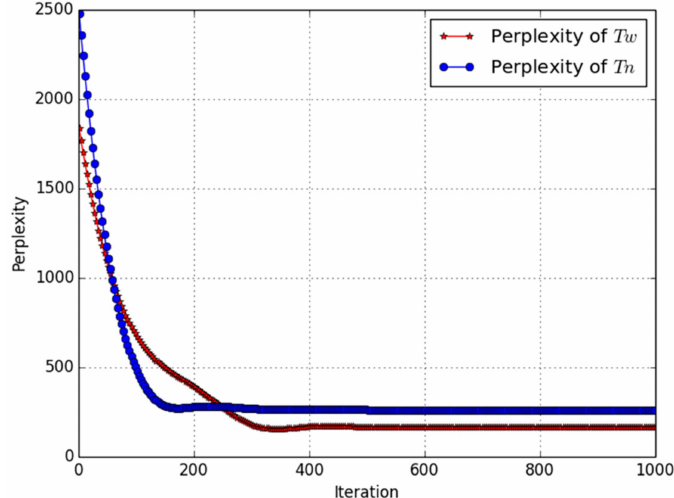
Figure 5. Average Perplexity of LDA for News and w -LDA for Weibo